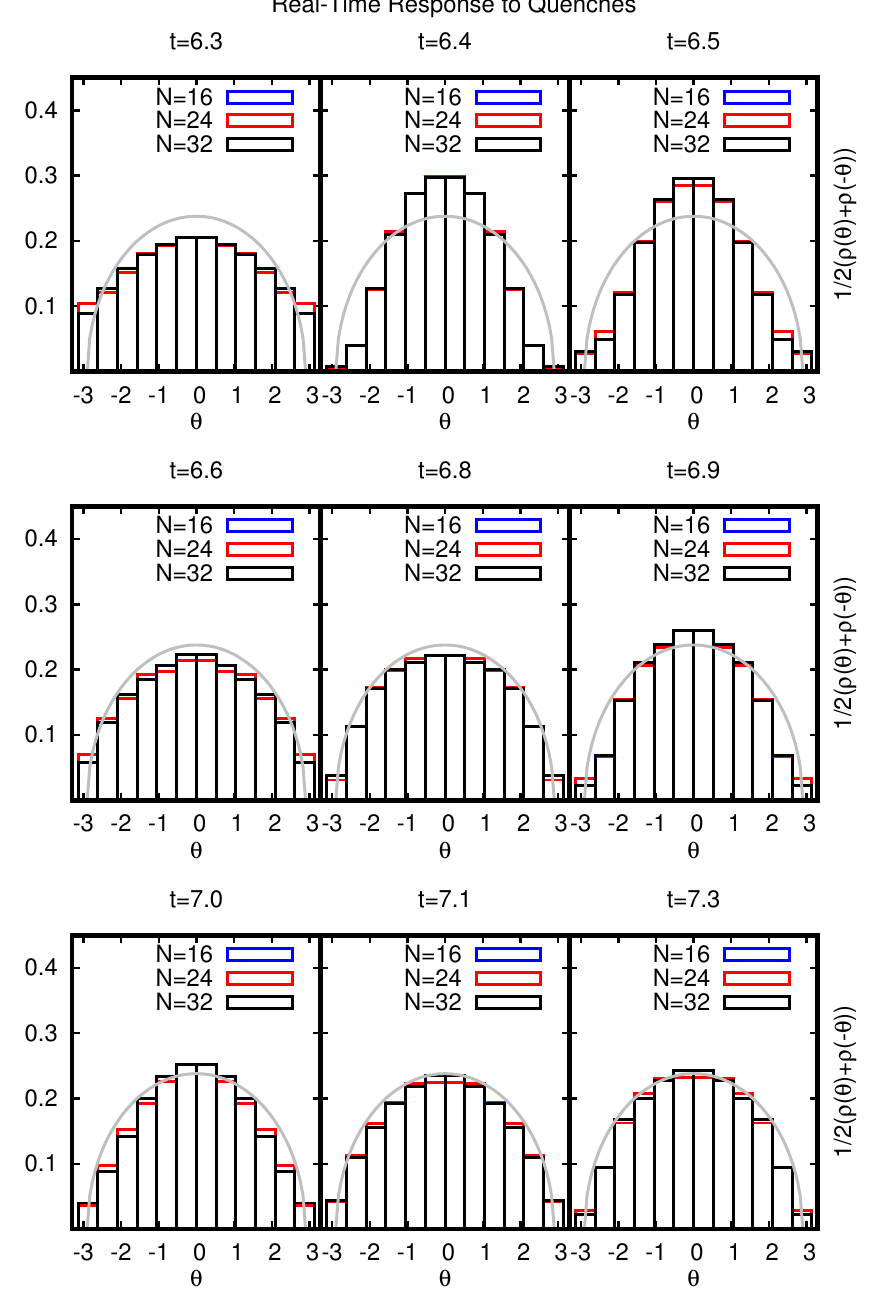
Figure 7 . Real-time response (left to right, top to bottom) of Wilson loop phase distributions to quench from E=N 2 = 1200 (black-string phase) to E=N 2 = 500 (black hole-phase) for N = 16, 24, 32, suggesting that results are almost independent from N . Quench was performed at t = 6 : 25 and grey line indicates new expected equilibrium con(cid:12)guration (2.13) with c = 2 : 92 based on E=N 2 =